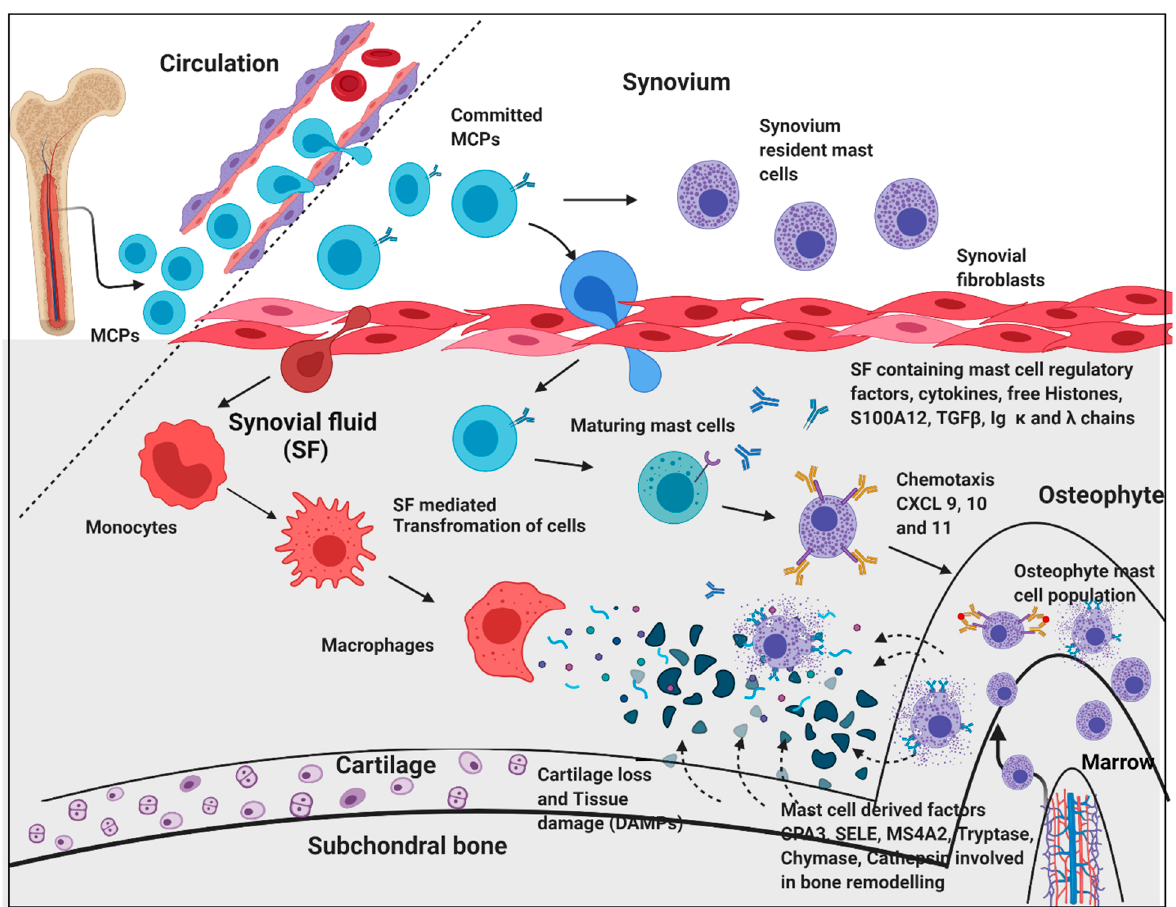
Figure 7. An overview of pathogenic dimension around osteophytes pertinent to mast cell action.